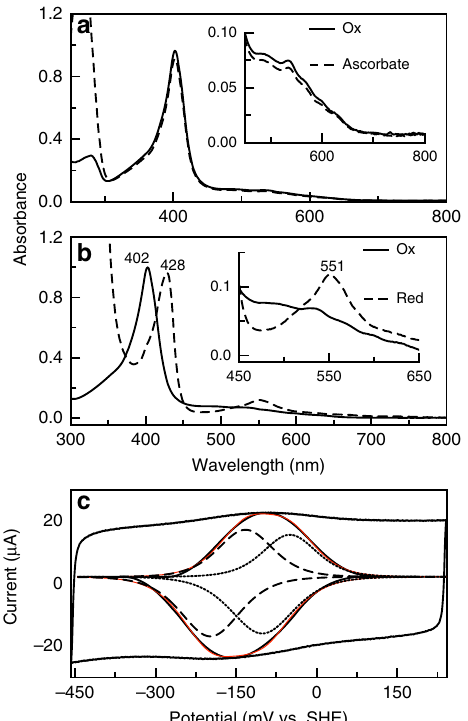
Fig. 2 Optical characterization of BthA. a Oxidized BthA (solid line) and ascorbate treated (dashed line). Ascorbate was added to 20 mM fi nal concentration before scan was collected. Inset shows range from 450 to 800 nm, indicating no signs of reduction to ferrous form. b Oxidized BthA (solid line) and dithionite treated (dotted line). Dithionite was added to a fi nal concentration of 1 mM. Inset shows peak formed at 550 nm. c Deconvoluted spectra of BthA on PGE. Voltammogram of BthA on MWCNT-PGE at pH 7, 21 °C, 100 mV s − 1 . Raw voltammogram is shown (black) with the baseline subtracted (black, inset) with fi t for the overall signal (red) and individual species (dotted and dashed